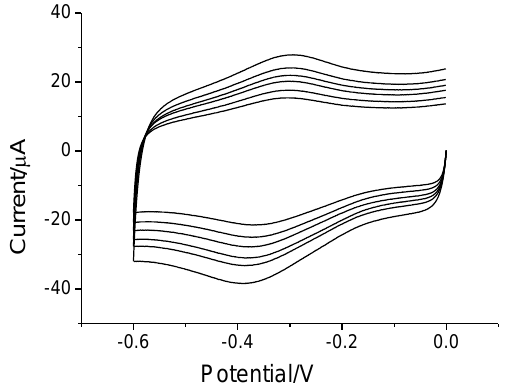
Figure 6. Cyclic voltammograms of Hb/FDU-15 modified electrode in pH 7.0 PBS at scan rate of 100, 125, 150, 175, 200 and 250 mV s −1